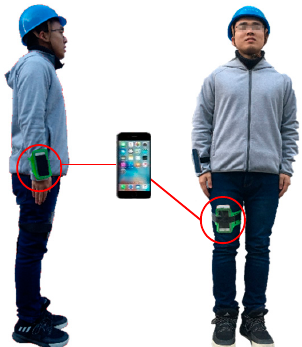
Figure 5. Schematic diagram of smartphone location.